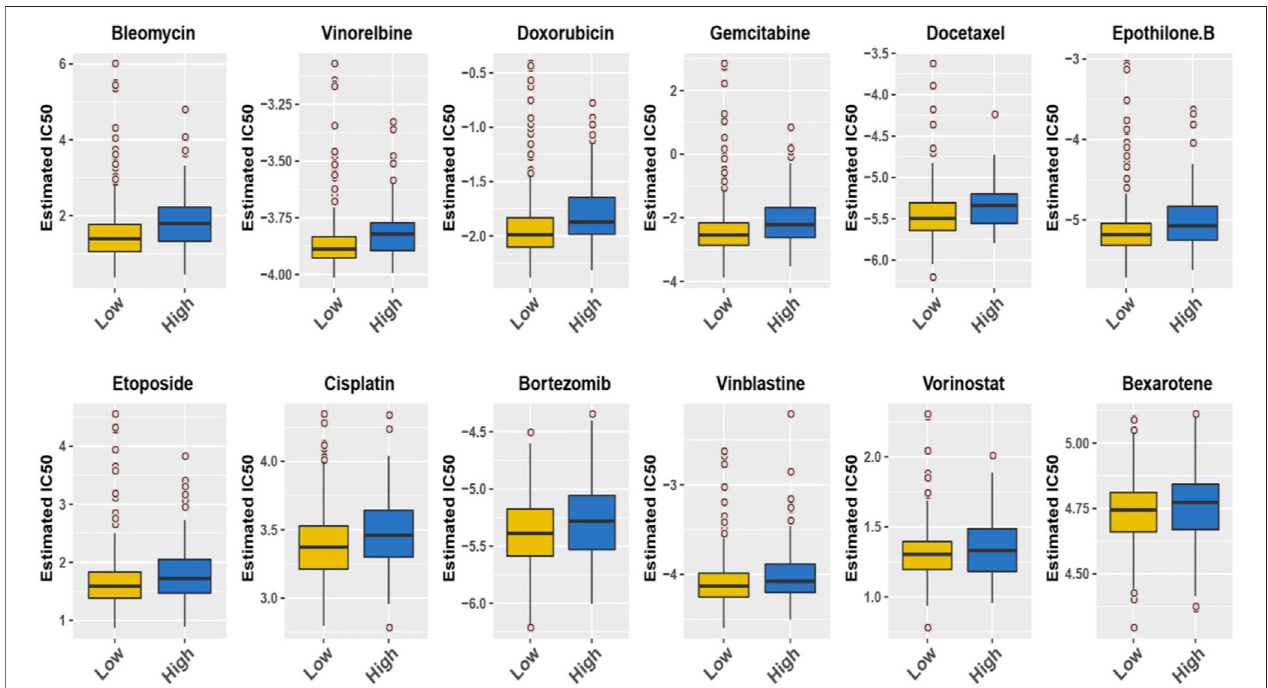
FIGURE 7 | The IC50s of 12 common chemotherapeutic agents with 11-SE-associated-gene signature.